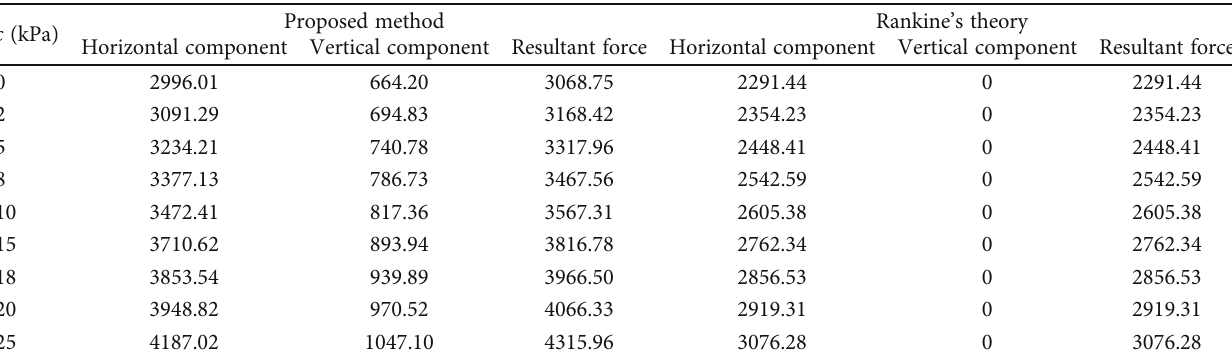
Table 2: The horizontal and vertical components of the passive earth pressure